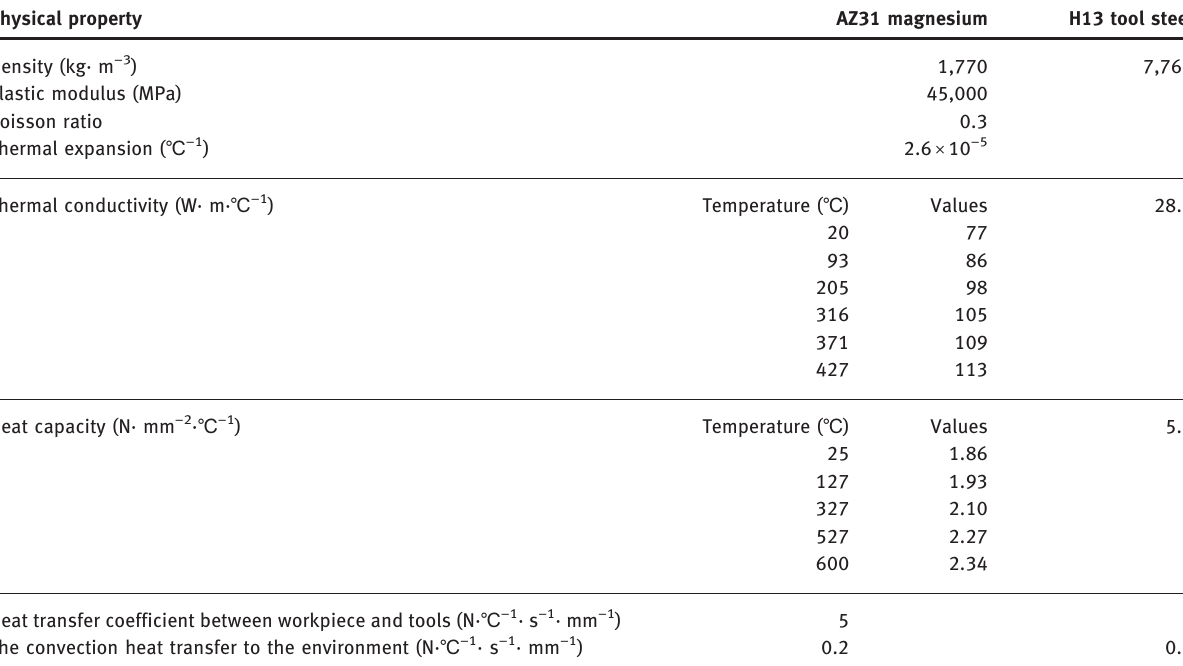
Table 1: Physical properties of the workpiece and